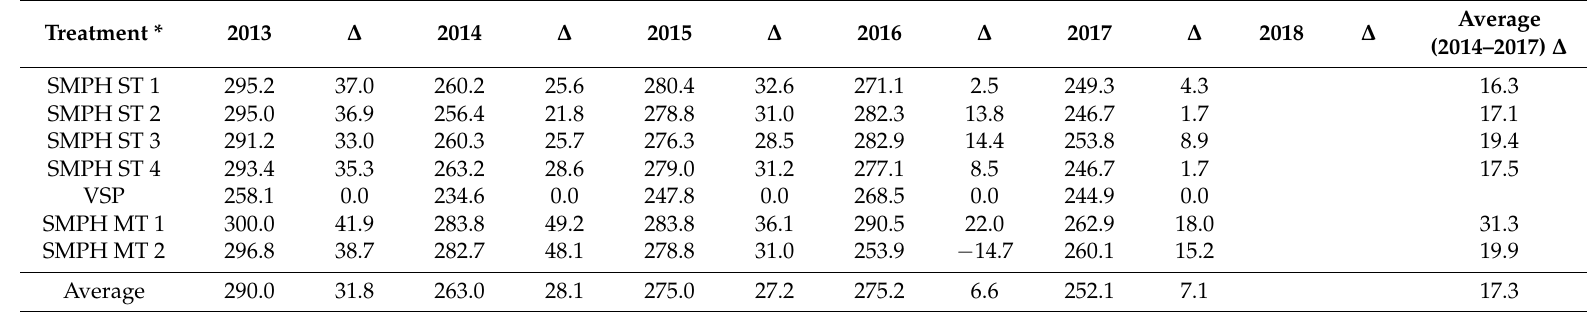
Table 1. Calculated dates (day of the year (DOY)) for reaching 5% bunch rot disease severity between 2013 and 2018 as well as deviations ( ∆ ) between the DOY for reaching 5% disease severity in one treatment in a specific year and the DOY for reaching 5% disease severity in the standard treatment, VSP, in that year. Average (2014–2017) deviations of different treatments are depicted. Since in 2018 5% disease severity were not reached in all treatments, calculated data were not